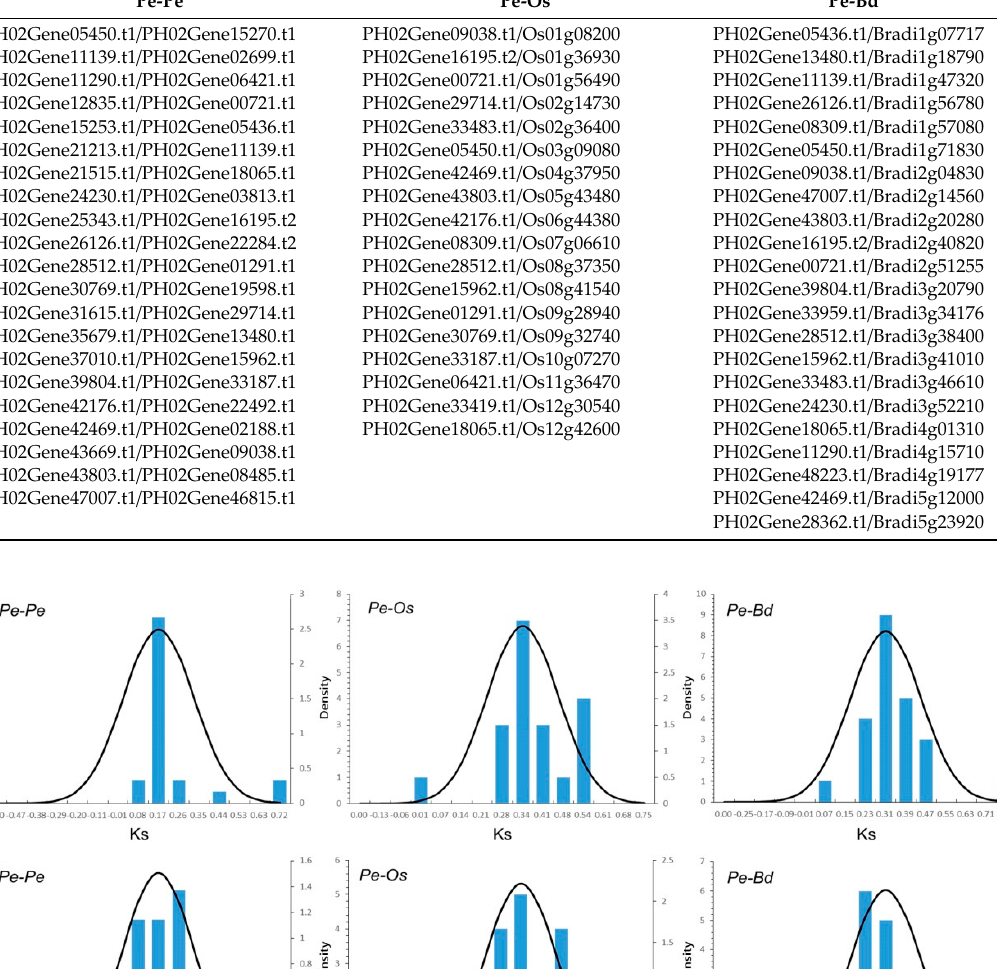
Table 2. Paralogous (Pe-Pe) and orthologous (Pe-Os and Pe-Bd) gene pairs.